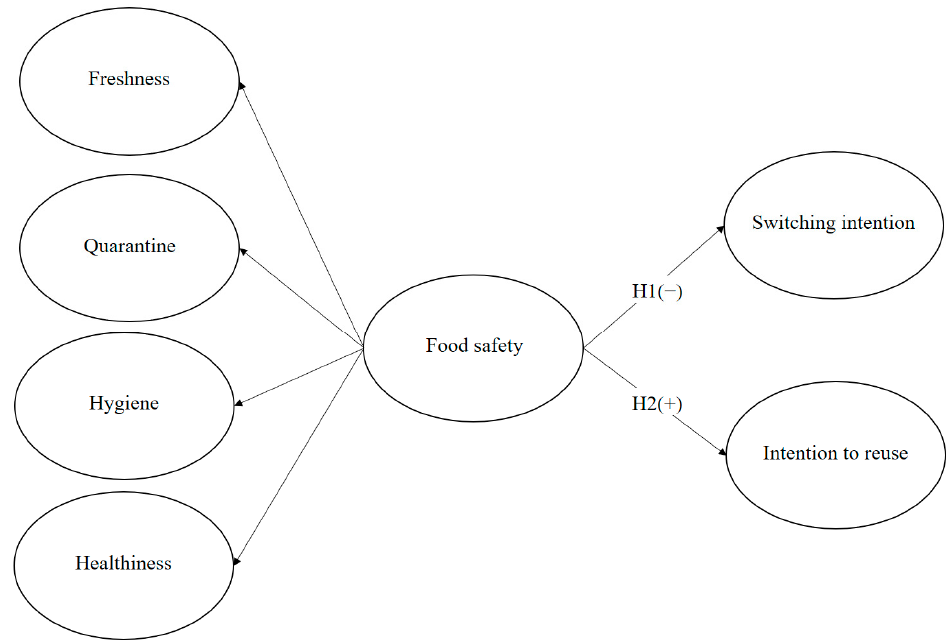
Figure 1. Research Figure 1. Research model.